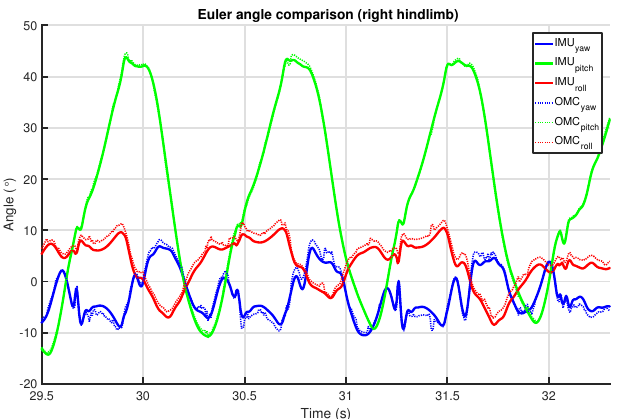
Figure 16. Example of the limb orientation match between IMU and OMC systems for the right